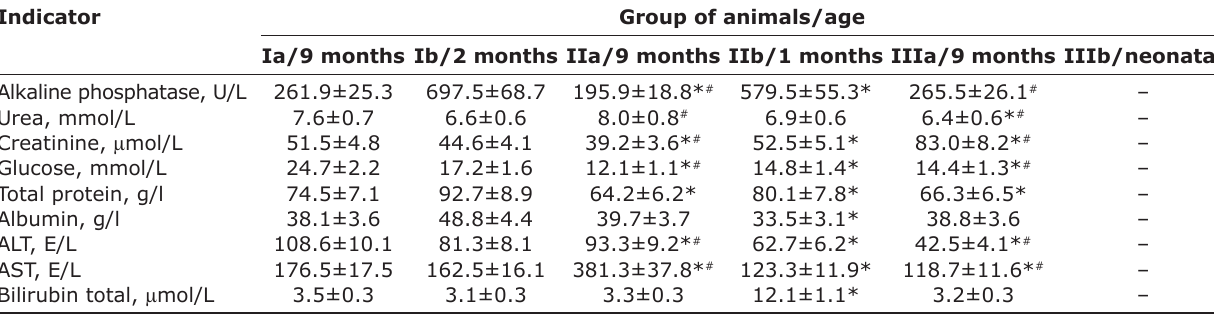
Table-5: Biochemical indices of rat blood (experiment of 3 months). Indicator